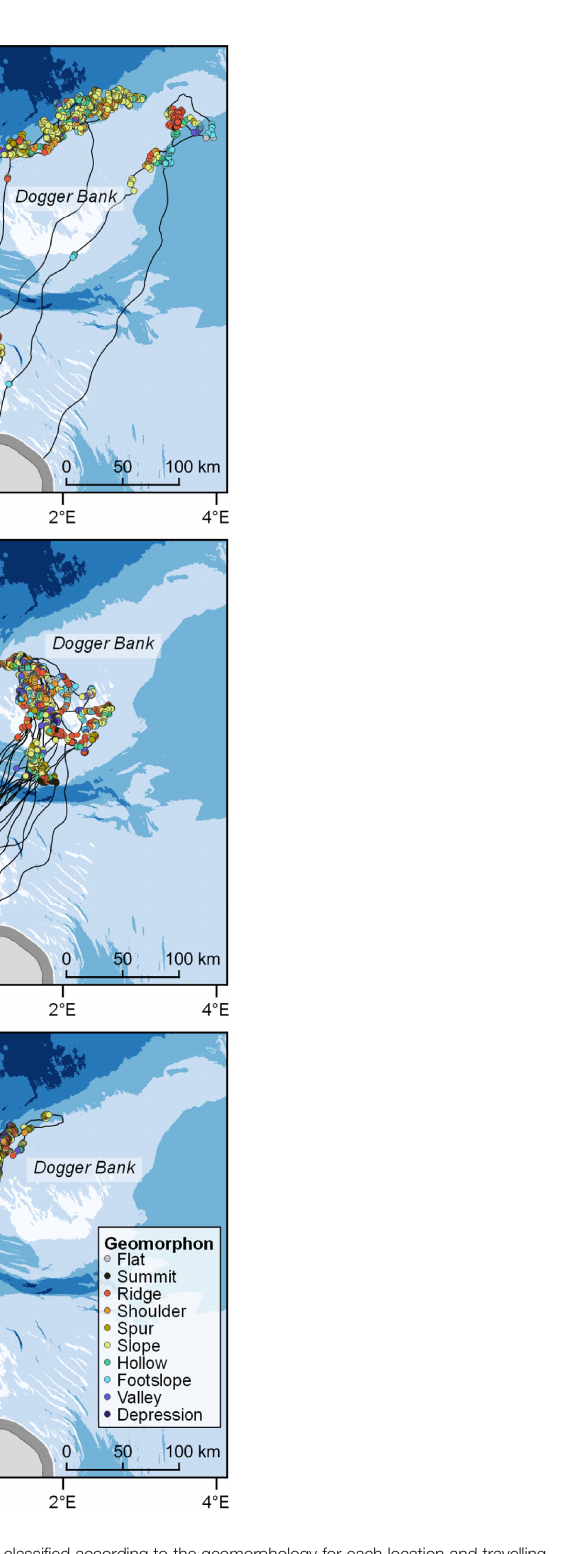
FIGURE 4 | Movement of (A) Seal 1, (B) Seal 2 and (C) Seal 3 with foraging locations classi fi ed according to the geomorphology for each location and travelling indicated by black lines. The 10 km coastal buffer within which locations were excluded is shown in dark grey. All three seals foraged in the vicinity of the Dogger